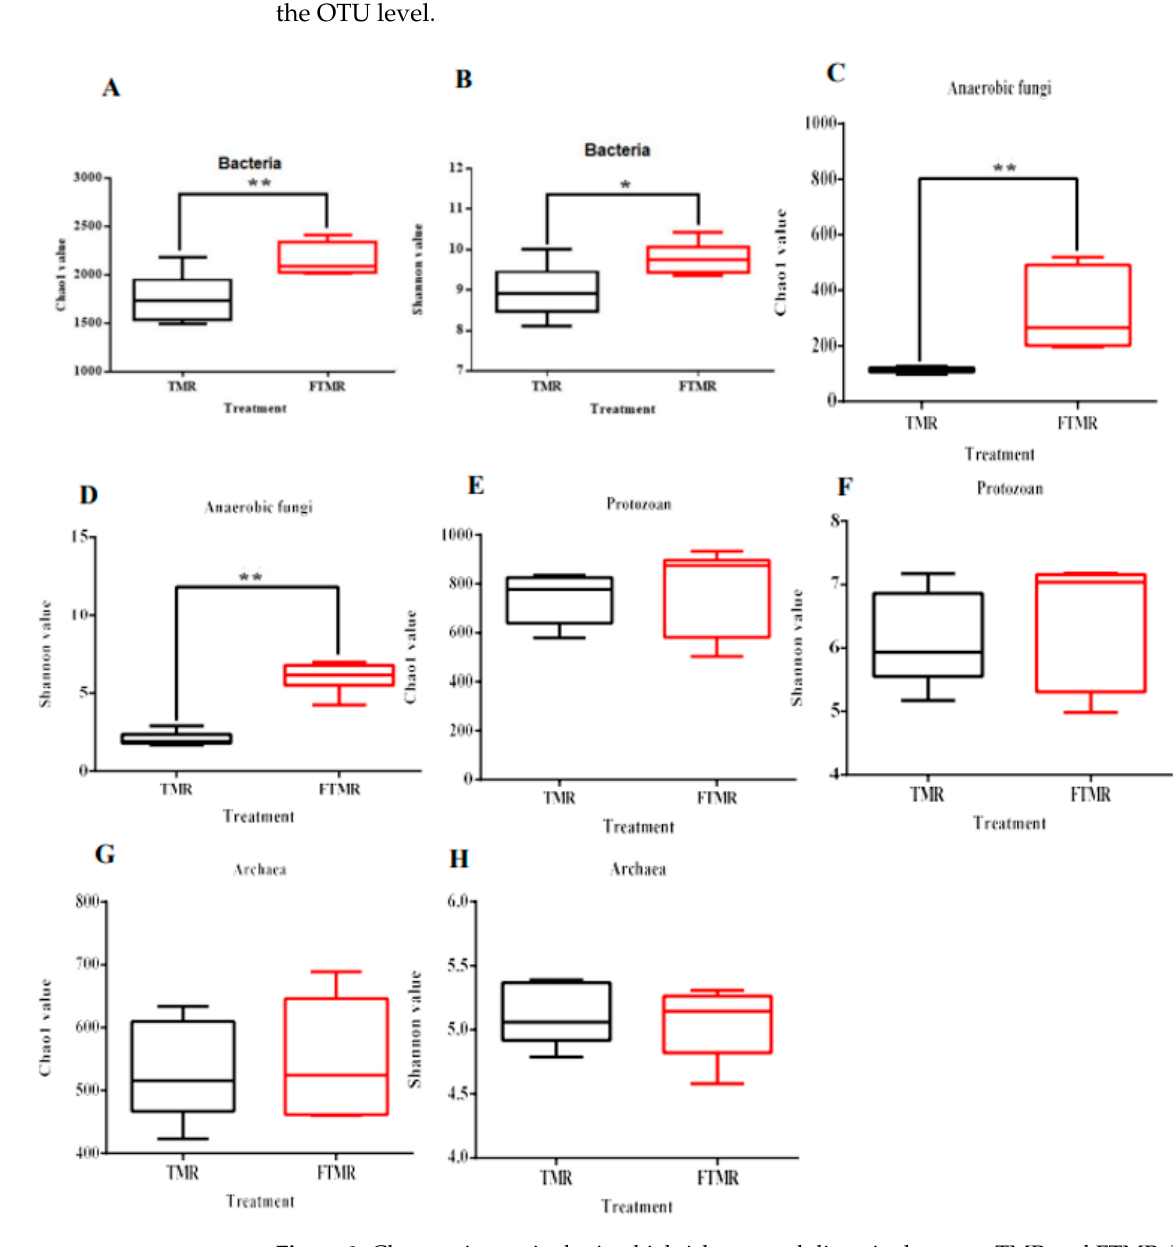
Figure 3. Changes in ruminal microbial richness and diversity between TMR and FTMR. Bacterial ( A ), anaerobic fungi ( C ), protozoan ( E ), and archaea ( G ) richness are estimated by the Chao1 value. Bacterial ( B ), anaerobic fungi ( D ), protozoan ( F ), and archaea ( H ) diversity are estimated by the Shannon index. Boxes indicate the interquartile range (IQR) between the first and third quartiles (25th and 75th percentile, respectively), and whiskers indicate the extremes of the data. Boxes with the different asterisk above their whiskers are significantly different (* p < 0.05 and ** p < 0.01, respectively) among treatments. TMR, total mixed ration; FTMR, fermentation total mixed